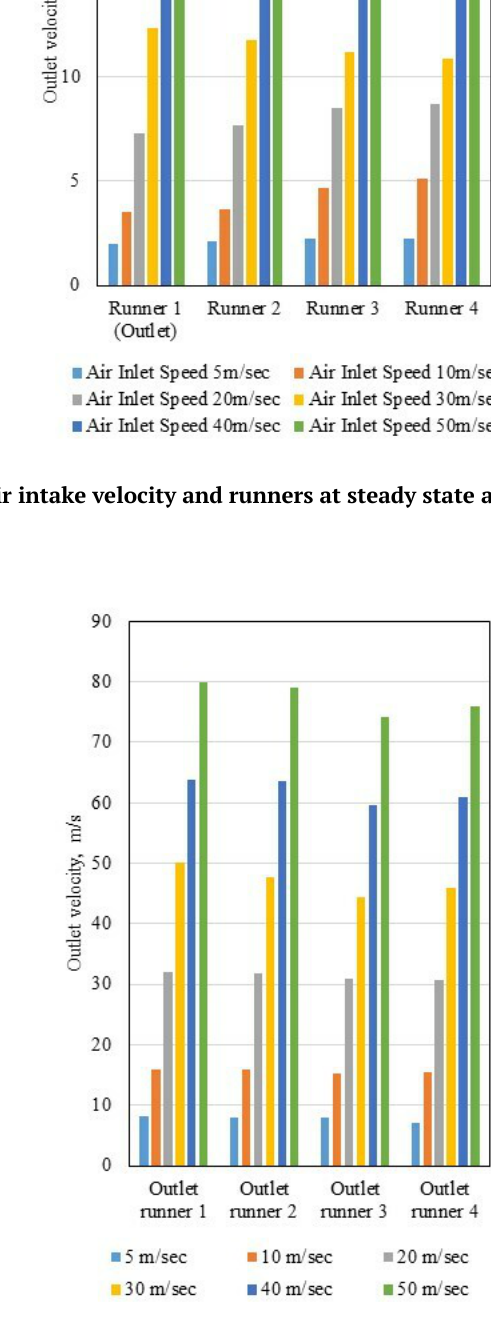
Fig. 11. Transient flow analysis for different runners by varying the air inlet